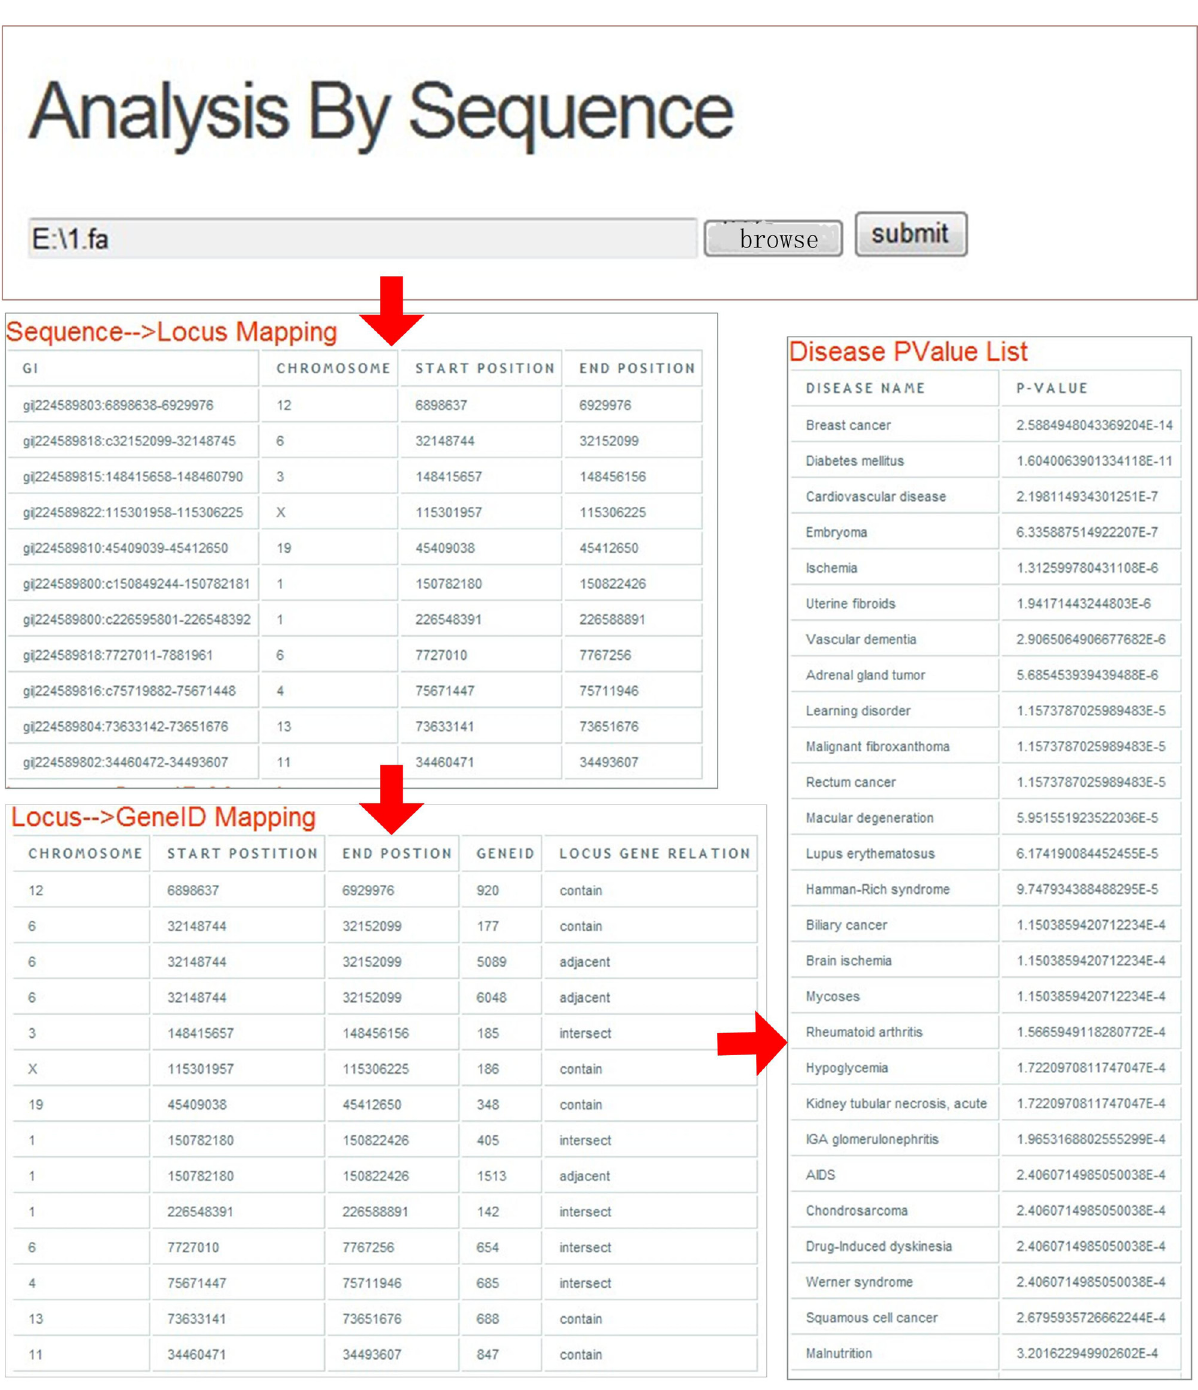
PLOS ONE | DOI:10.1371/journal.pone.0157274 June 17,